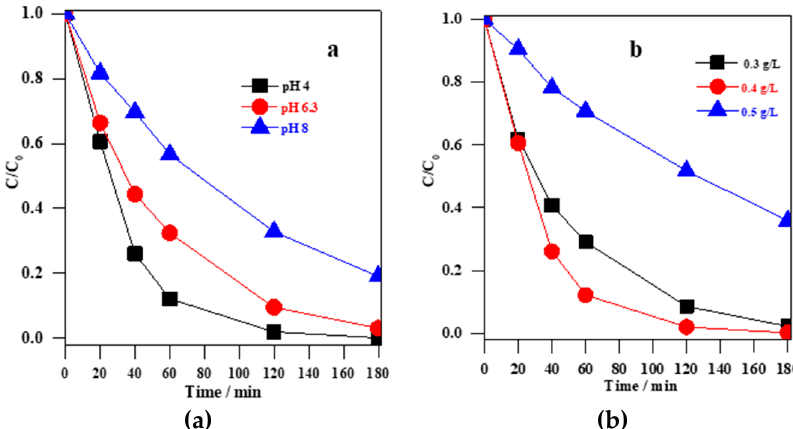
Figure 10. ( a ) Photodegradation of 10 mg L − 1 MC-LR in the presence of CDT-0.00 (0.4 g L − 1 ) under visible irradiation at different pH values (4, 6.3, and 8); and ( b ) photodegradation of 10 mg L − 1 MC-LR using different dosages of CDT-0.00 (0.3, 0.4, and 0.5 g L − 1 ) under visible irradiation at pH 4.